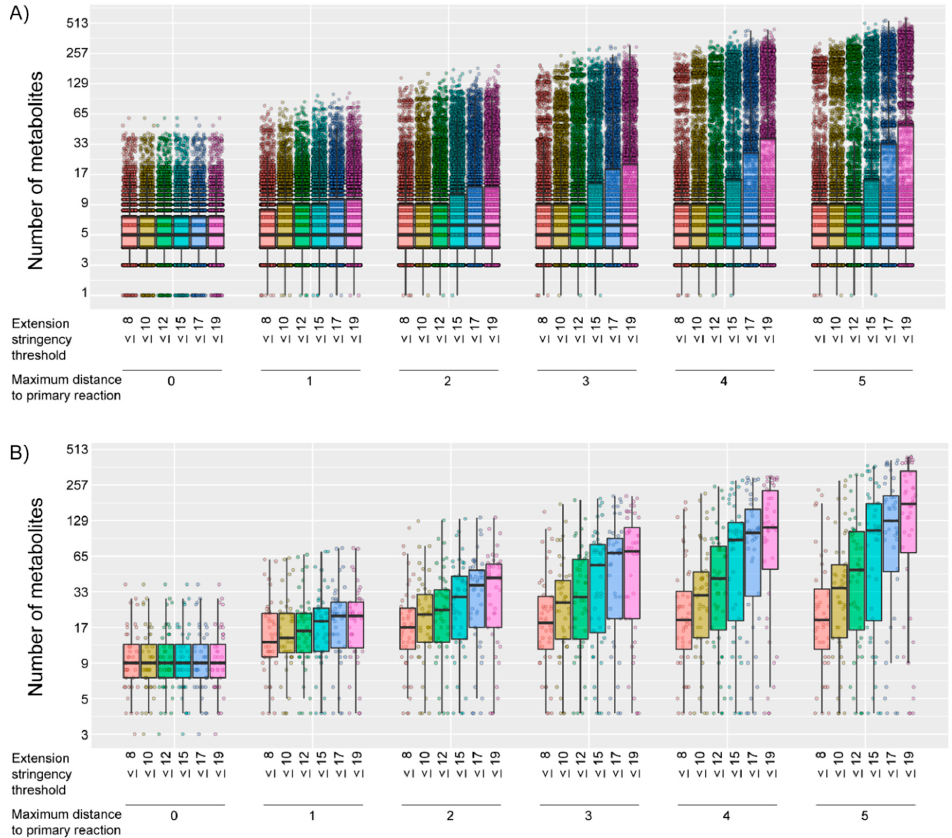
Figure 1. Number of metabolites on a logarithmic scale (log2 (“number of metabolites” + 1)) within the gene-specific metabolite set, for ( A ) all 7033 genes and ( B ) each of the 44 disease-causing genes with a gene-specific metabolite set that consisted of at least 1 metabolite in any parameter combination. The number of metabolites is stratified by the first studied parameter: maximum distance to the primary reaction and by the second studied parameter: the extension stringency threshold. Boxplots indicate the distribution of the number of metabolites in the gene-specific metabolite sets. Each dot represents one gene-specific metabolite